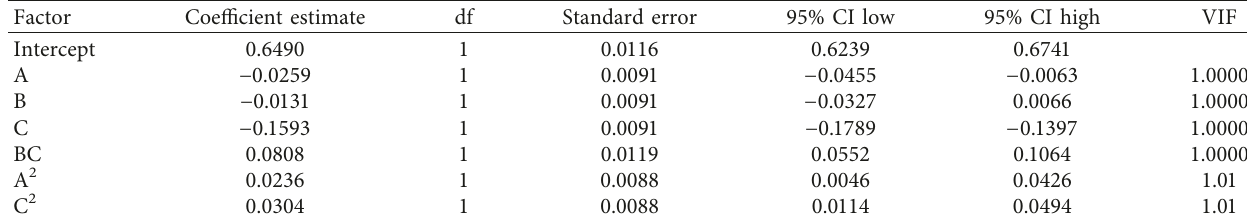
Table 5: Significant test of the regression coefficients.